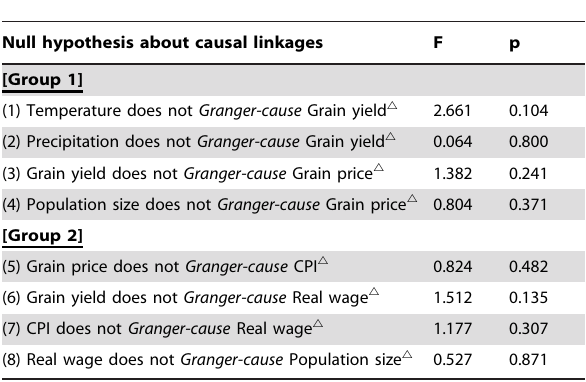
Table 4. GCA Results for Each of the Causal Linkages by High-Pass Filtered